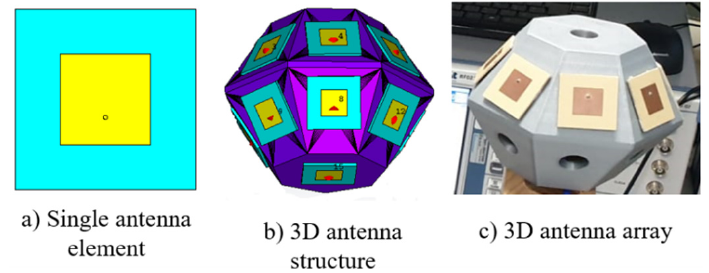
Figure 1. 3D antenna array design.